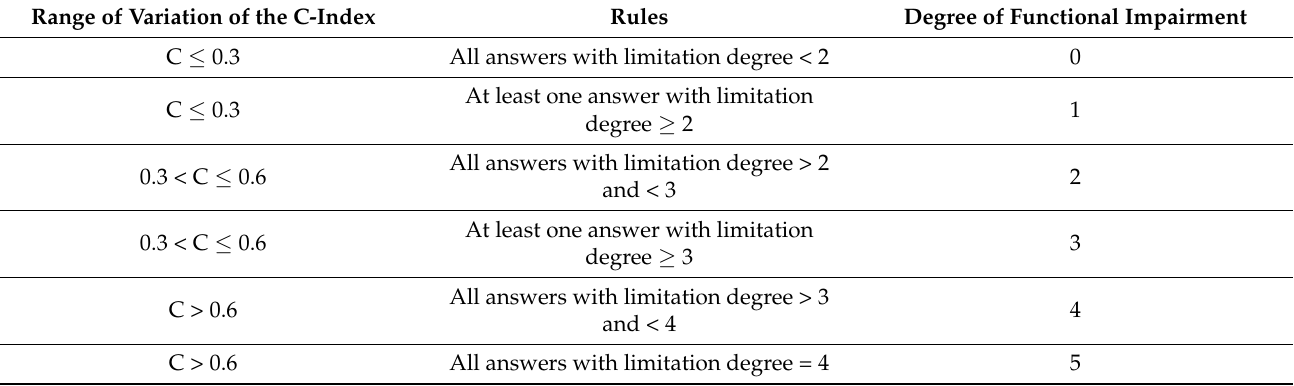
Table 1. Level of functional jaw